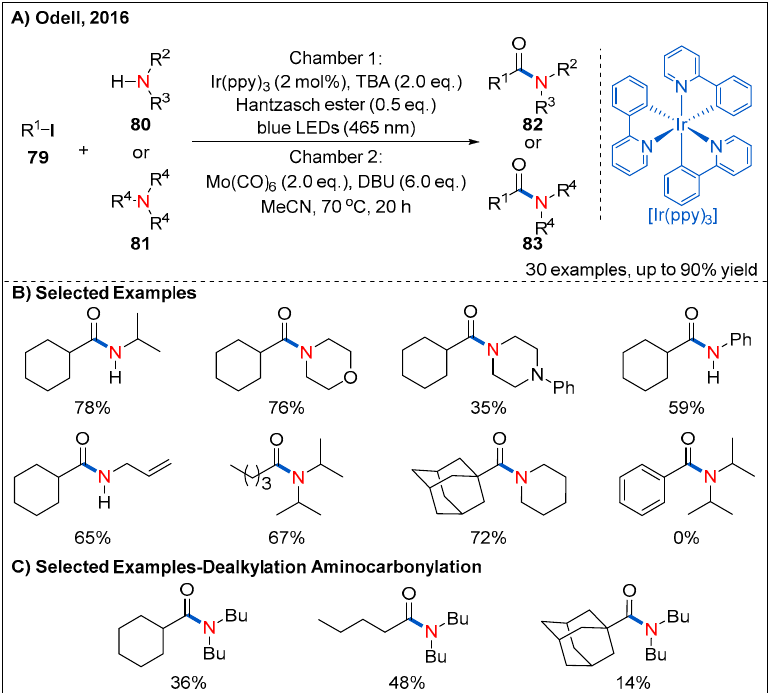
Figure 26. Photoinduced radical aminocarbonylation of unactivated alkyl iodides under low pressure of ex situ-formed CO.